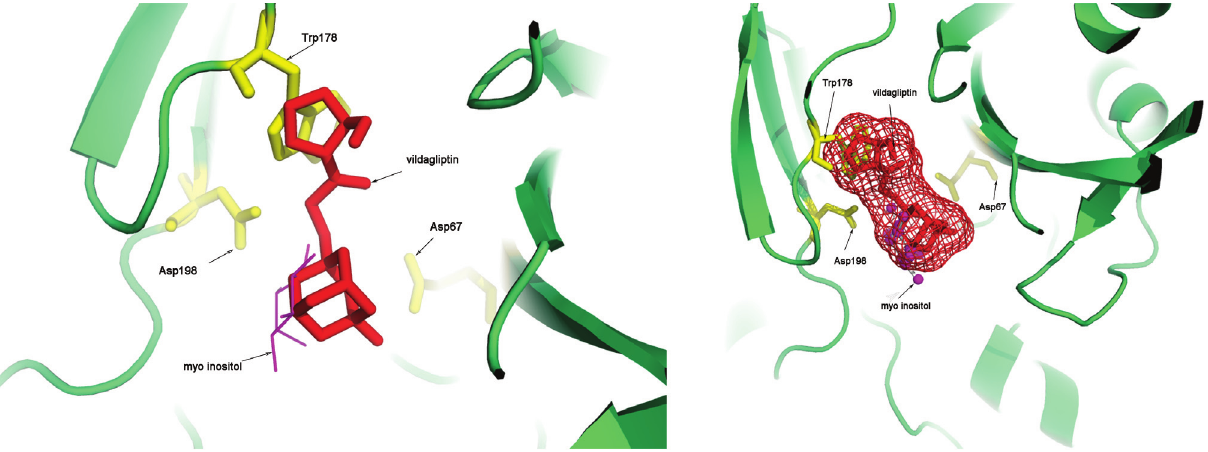
Figure 2. Docking vildagliptin to the PI-PLC structure in complex with myo-inositol (PDBid:1PTGA). It can be seen that vildagliptin fits into the binding site of PI-PLC. It also makes non-hydrophobic contacts to the residues in the protein similar to those made by myo-inositol (Table 5).